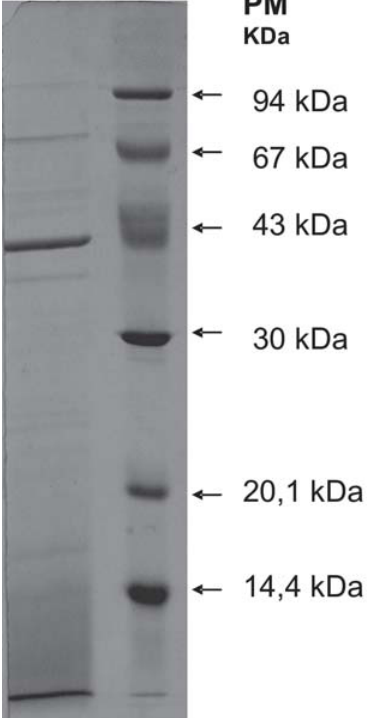
FIGURE 3- SDS-PAGE profiles of sonicated cell extracts from P. gingivalis ATCC 33277. The separated proteins were stained by Coomassie Brilliant